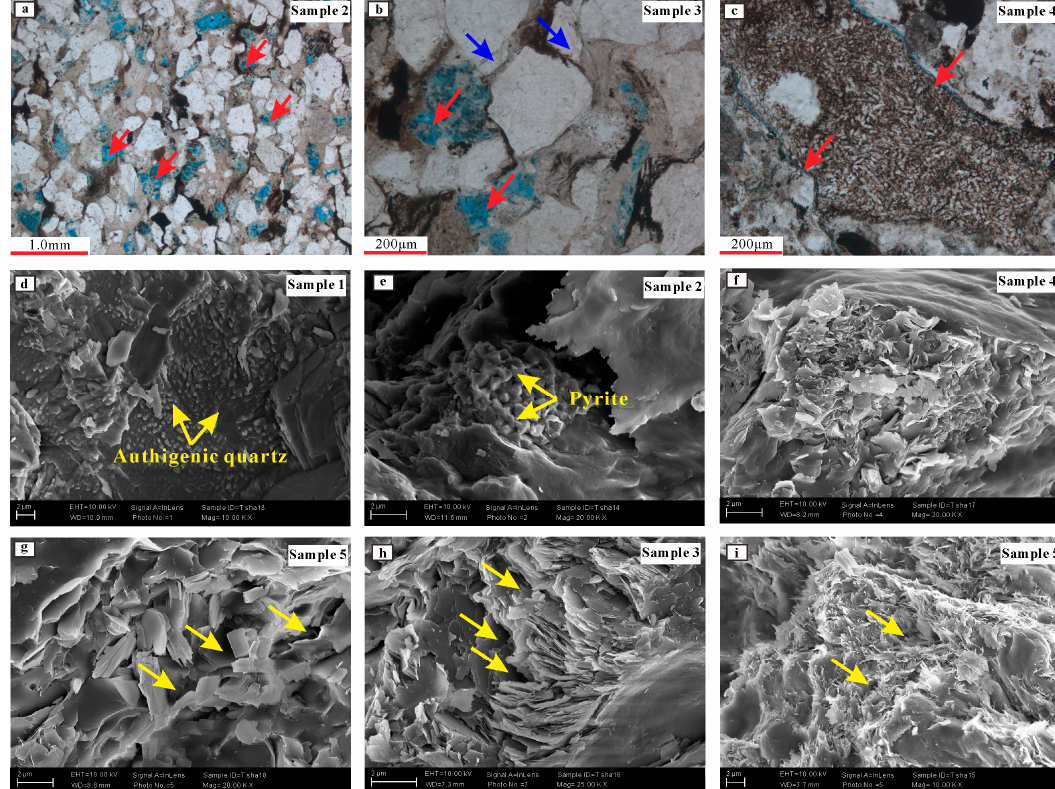
Figure 3. Photomicrographs showing the microscopic pore structure characteristics of P 1 t tight sandstone. ( a ) sandstones with intergranular and intragranular dissolution pores (red arrow) and extensive quartz overgrowths; ( b ) intragranular dissolution pores (red arrow) and quartz overgrowths (blue arrow); ( c ) dissolution pores occur on detrital grain edges (red arrow); ( d ) fine authigenic quartz grains; ( e ) pore-filling pyrites; ( f ) authigenic clay minerals fill the dissolution pores; ( g ) slablike kaolinite filling in the pore; ( h ) flaky illite filling in pore; ( i ) hair-like illite/smectite mixed layers filling in pore (yellow arrow, micropores associated with clay minerals).